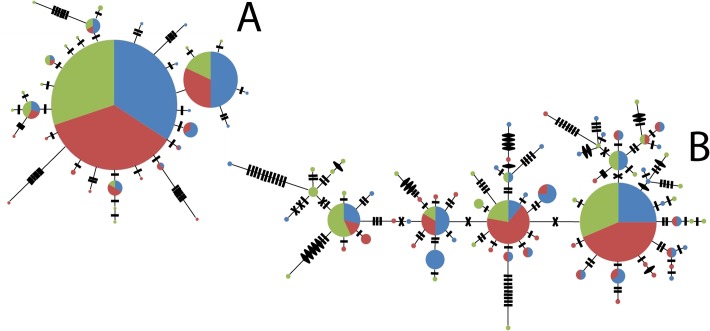
Unrooted minimum spanning network for mtDNA Control Region sequences.A represents sequence data only; B represents sequence and indel data. Each circle represents a haplotype where the size of the circle is directly proportional to haplotype frequency and pie slices indicate proportions of haplotypes from each region (Campeche Bank—black; South West Florida Shelf—dark grey; North West Florida Shelf—light gray). Hash marks (█) indicate 1 step difference between sequences. Crosses (χ) indicate a 40-bp indel repeat difference. Diamonds (♦) indicate a 9-bp indel repeat difference.